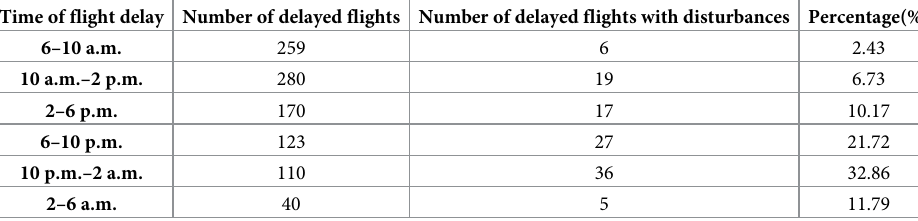
Table 2. Statistics on the time of flight delay and passenger disturbance at Shenzhen Airport, 2018.